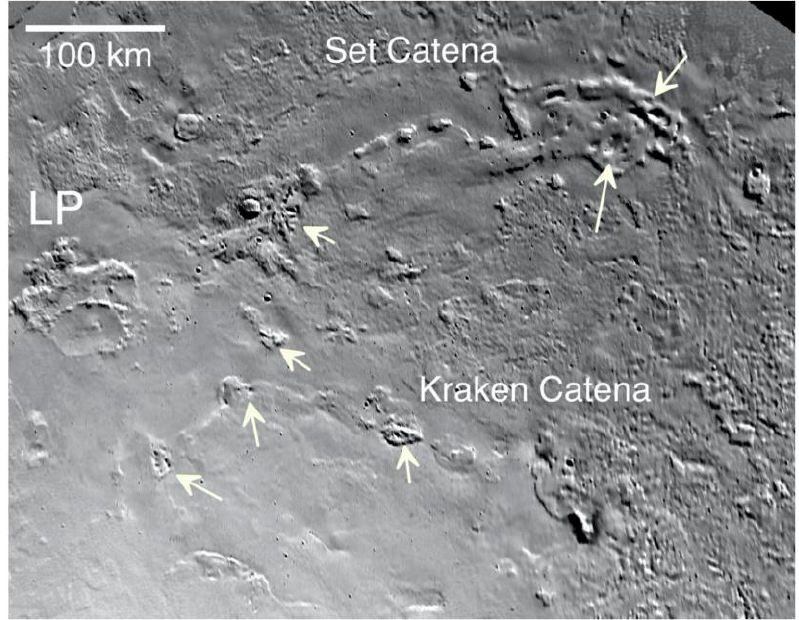
Figure 16. Volcanic plains of Cipango Planum showing spatial association of Leviathan Patera (LP) and Set and Kraken Catena pit chains. Arrows highlight knobs discussed in text. Scene width ~540 km.